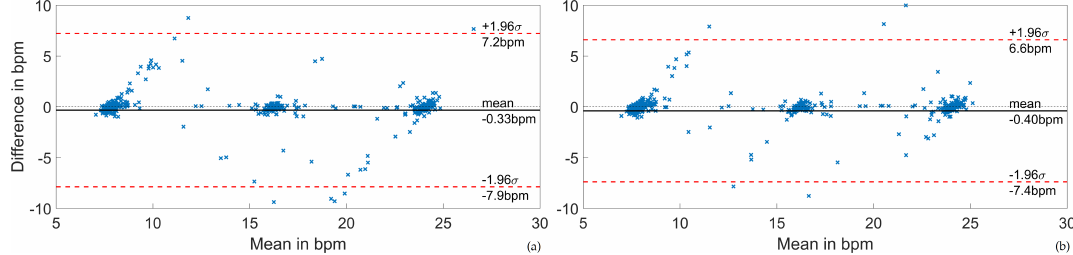
Figure 13. Performance plots of the EDR and PDR based RR estimations over all positions including outliers. ( a ) Correlation optimization. ( b ) Respiration rate optimization.